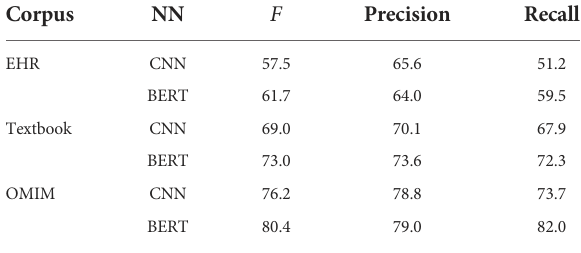
TABLE I. Performance of CNN and BERT neural networks on concept extraction task. Corpus